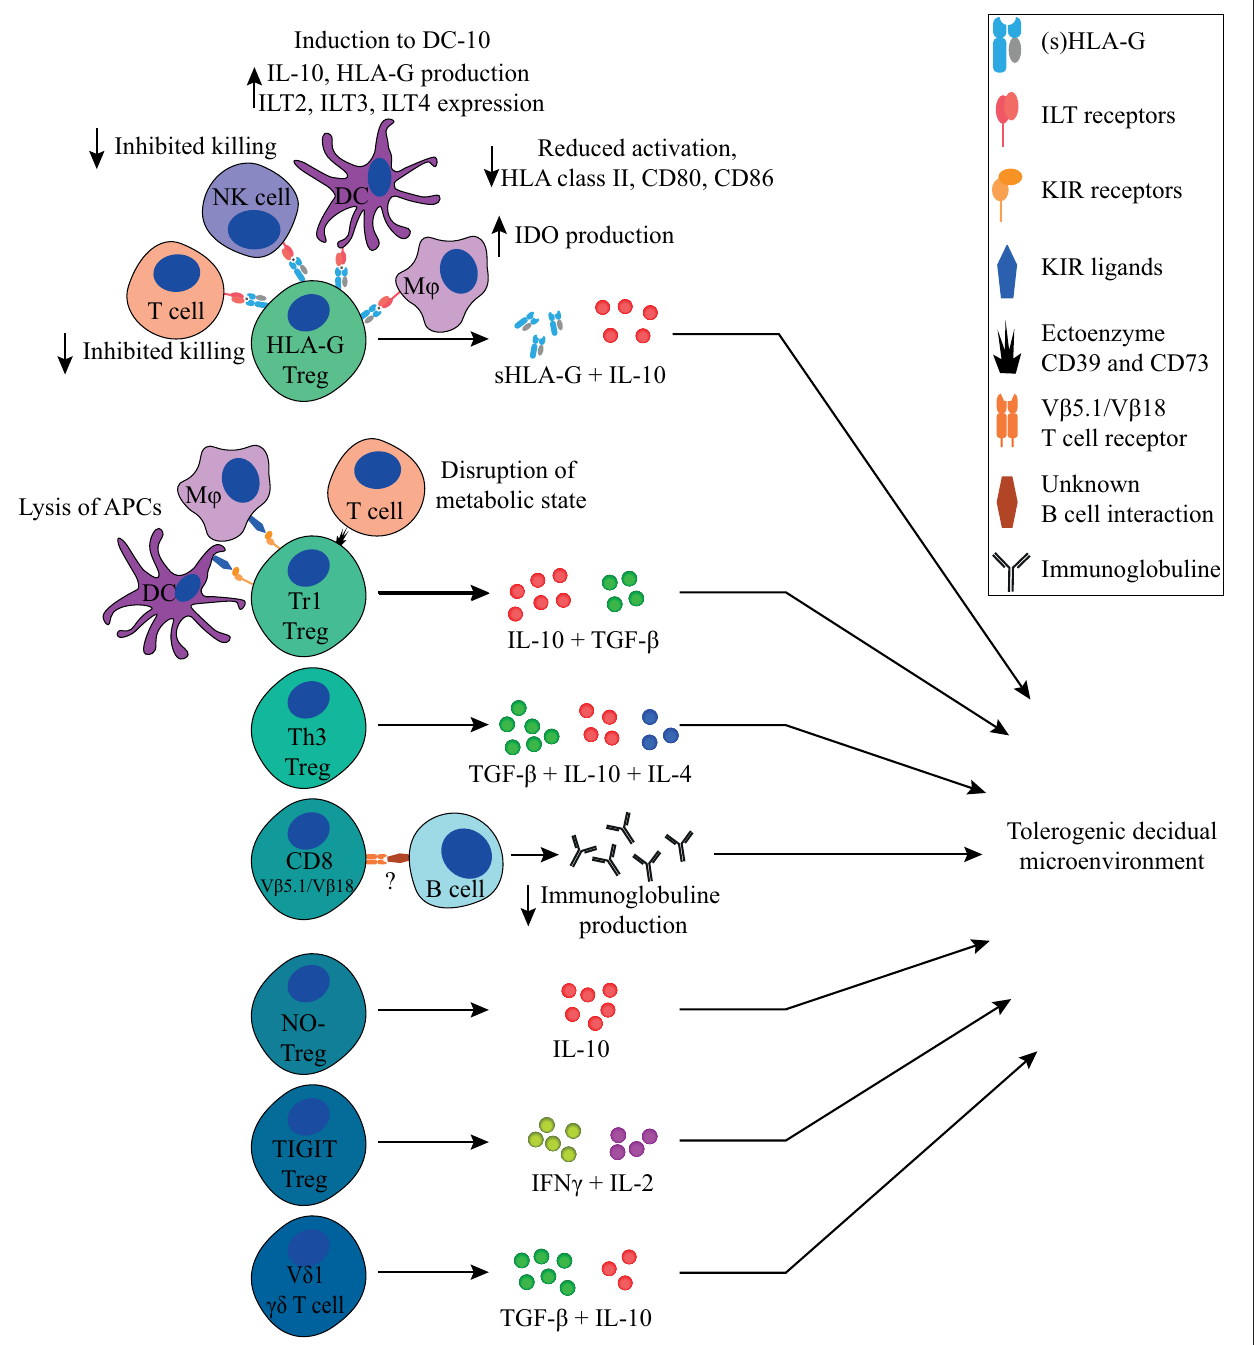
FIGURE 5 | Overview of FoxP3 − immune regulating T cells discussed in this review and their main tolerogenic mechanisms in pregnancy. All Tregs described in this review can exert immunosuppressive properties in a cell-contact independent mechanism that together contributes to a tolerogenic decidual microenvironment. Next to that, the HLA-G + Treg, Tr1 Treg, and CD8 + Treg can exert their immunosuppressive properties in a cell-contact dependent mechanism.